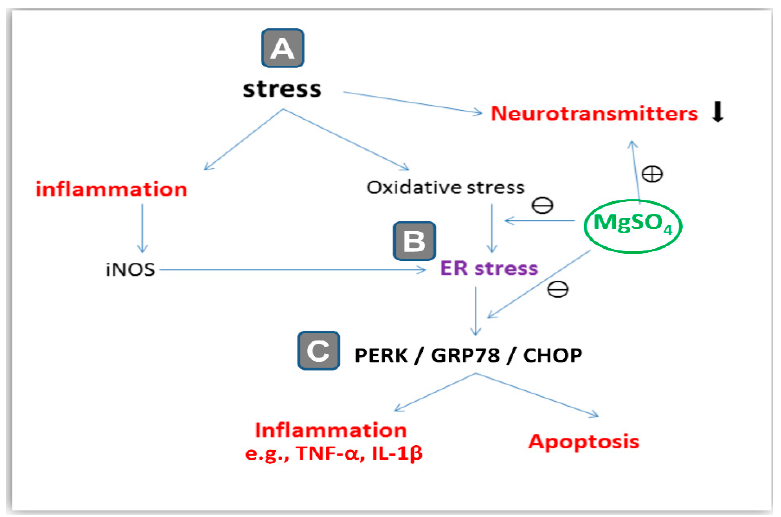
Figure 10. An overview of the underlying mechanisms that explain the observed antidepressant effect of magnesium sulfate against stress-induced depression-like behavior in rats. ( A ) Exposure to chronic restraint stress (CRS) resulted in the depletion of neurotransmitters, exaggerated oxidative stress, and inflammation in the hippocampi of rats. ( B ) The excessive pro-oxidant/pro-inflammatory responses triggered the endoplasmic reticulum (ER) stress with an accumulation of misfolded proteins in the ER. ( C ) The later event was marked by activation of PERK/GRP78/CHOP pathway which culminates in neuronal inflammation and apoptosis. Interestingly, magnesium sulfate inhibited the ER stress and the linked activation of iNOS/PERK/GRP78/CHOP pathway and suppressed the pro-oxidant/pro-inflammatory signals. These actions prompted the augmentation of the monoamine neurotransmitters in the hippocampi of rats, culminating in improvement of the depression-like behavioral deficits triggered by CRS. ⊕ indicates stimulation while ⊖ indicates inhibition. PERK, protein kinase RNA-like endoplasmic reticulum kinase; GRP78, glucose-regulated protein 78-kDa; CHOP, C/EBP-homologous protein.